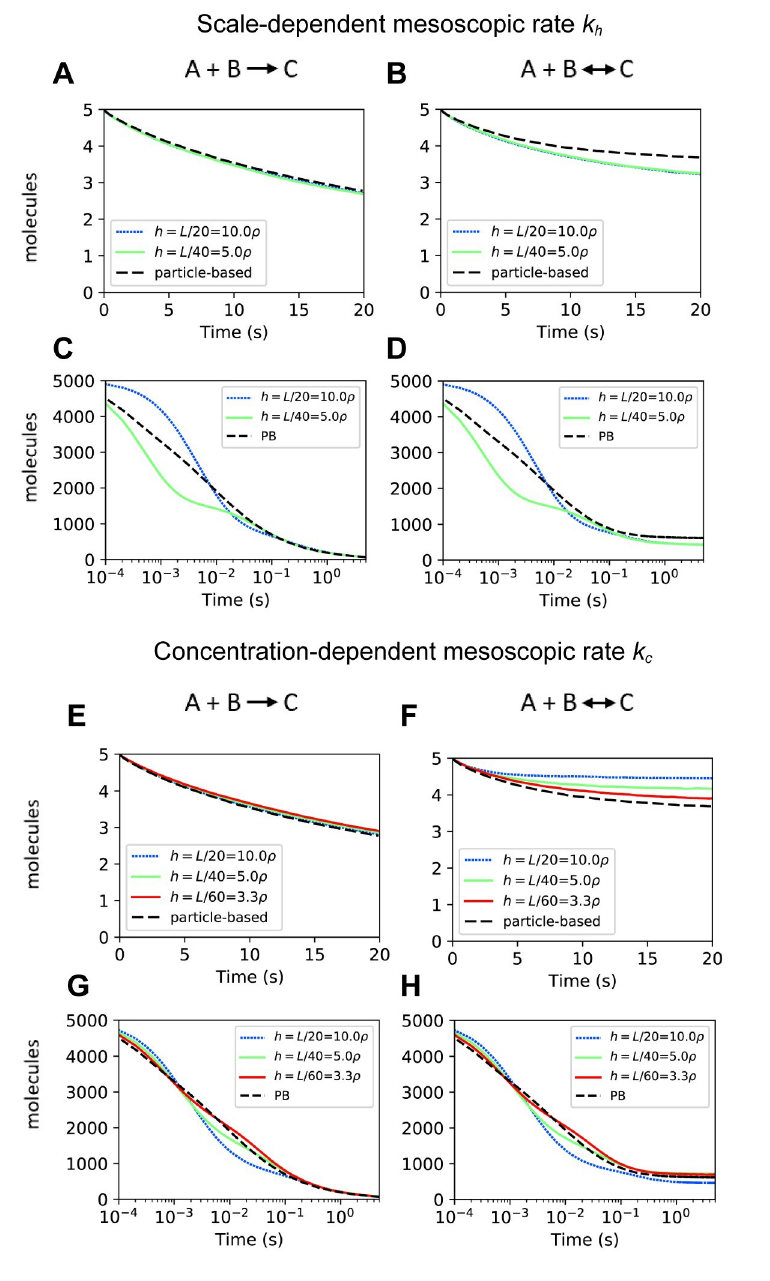
Fig 2. Comparison of spatial Gillespie simulations using the mesoscopic rates k simulations. (A-D) Results for the mean number of species A from spatial Gillespie simulations using the mesoscopic rate k with initial low abundance of reactants in (A, B) (total A = total B = 5, total C = 0 at t = 0) and initial high h abundance (total A = total B = 5000, total C = 0 at t = 0) in (C-D) . (E-H) show corresponding simulations to (A-D) but using the mesoscopic rate k . In all the simulations, the degree of diffusion control is λ πρ 2 / D tot = 50, with D tot = 2 D and c D = 0.0025 μ m 2 /s, ρ = 0.005 μ m and λ = 3183.1/s. The size of the domain is L = 1 μ m. For the reversible reaction A+B $ C, the microscopic dissociation rate constant k d micro is 1/s in (B, F) , and 10/s in (D, H) .